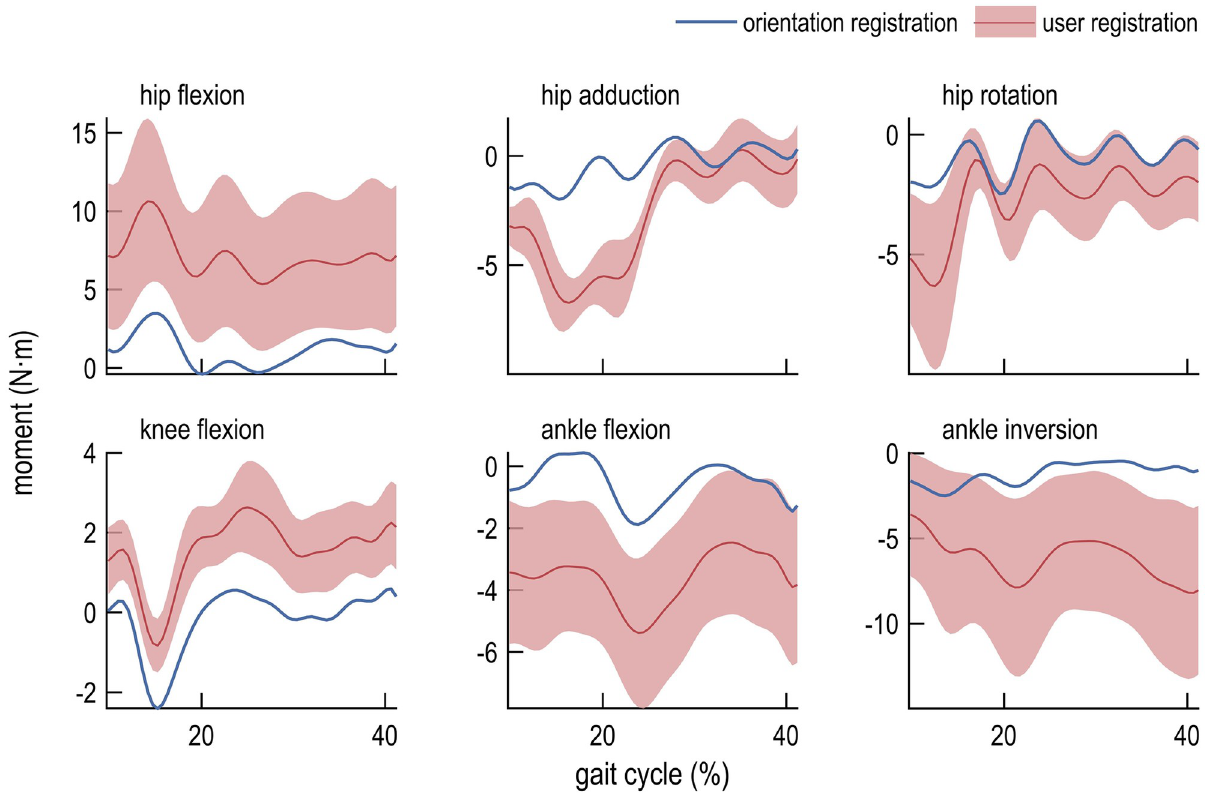
Fig 6. Errors in inverse dynamics calculations for orientation and user registration methods. Errors in joint moments were computed relative to the joint moments from the encoder-registered model during single-leg stance using orientation registration (blue line) and user registration (mean, red line; standard deviation, shaded).